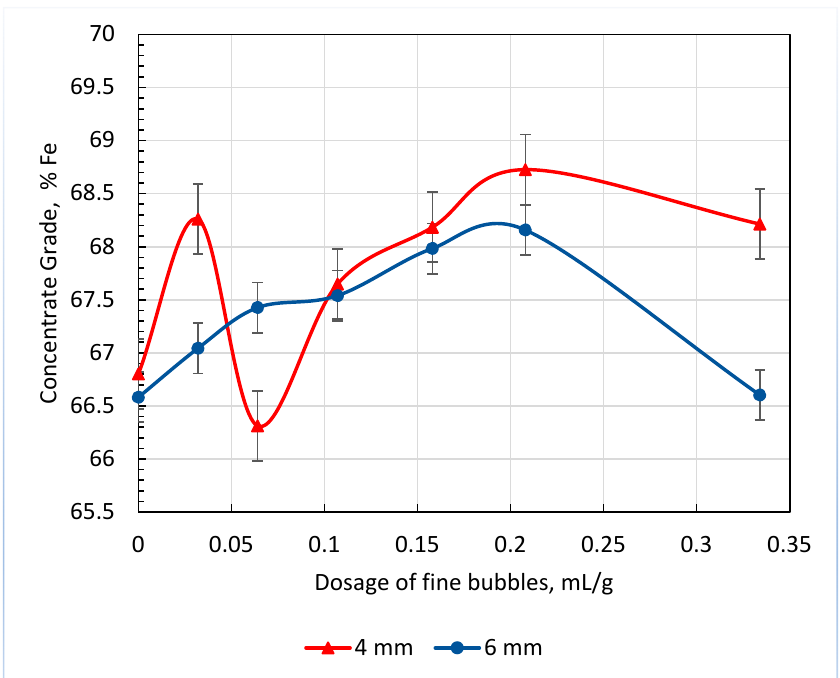
Figure 12. Dependence of the concentrate grade on fine bubble dosage upon treatment in TFRs having 4 and 6 mm inner diameters. CTAB dosage—20 g/t, treatment time—7.5 s. (Error bars represent the standard deviation obtained from 3 test repeats).